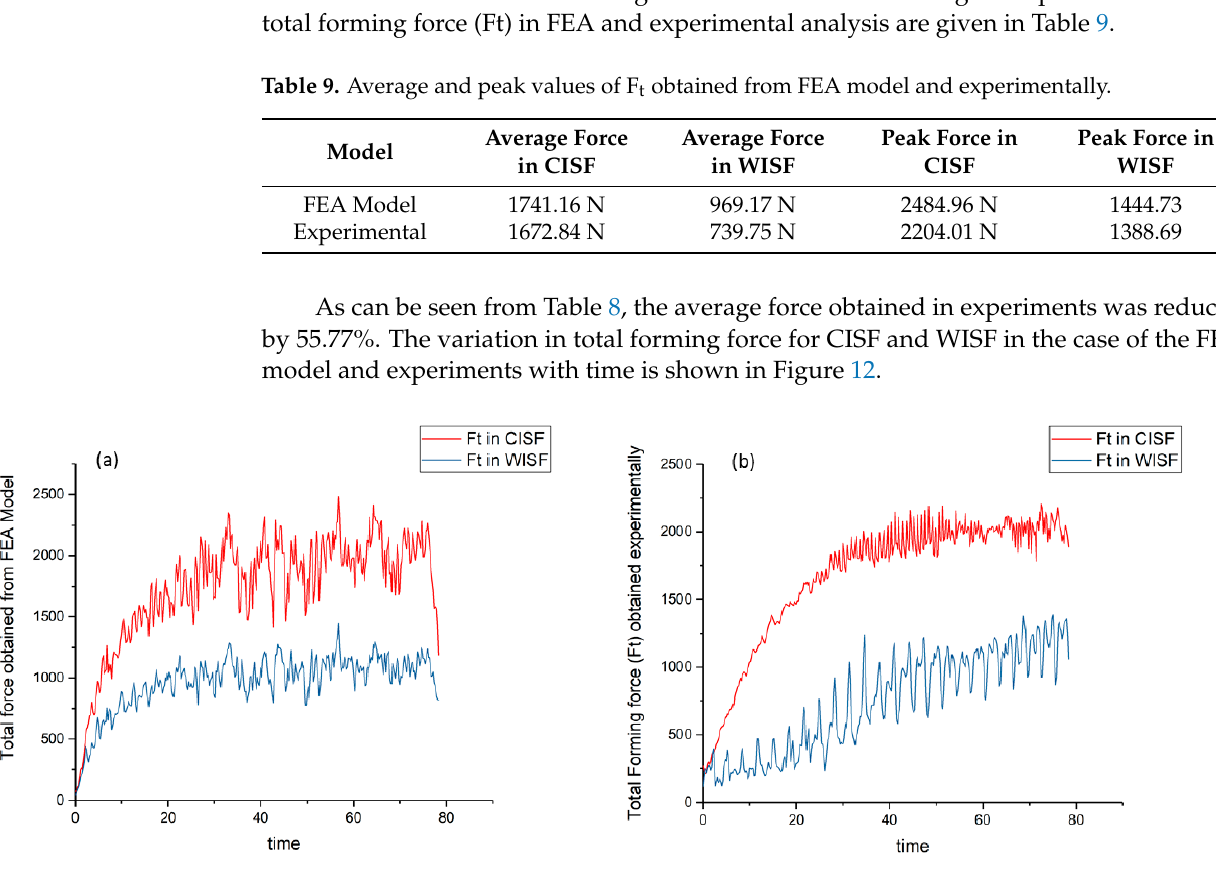
Figure 11. Comparison of Z-component of forming force: ( a ) comparison of F y in FEA modeling and ( b ) comparison of F y obtained experimentally.